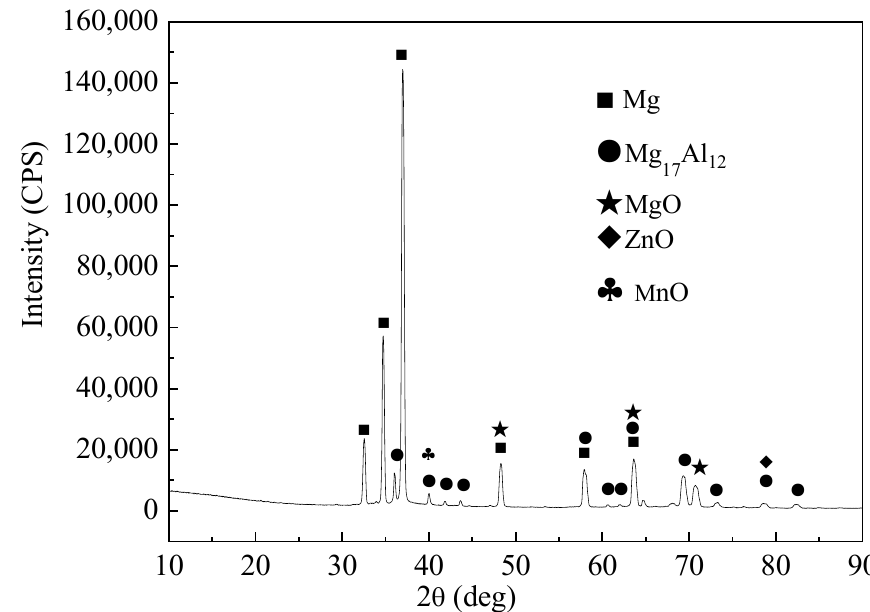
Figure 3. XRD pattern of the AZ80 alloy in A-zone.